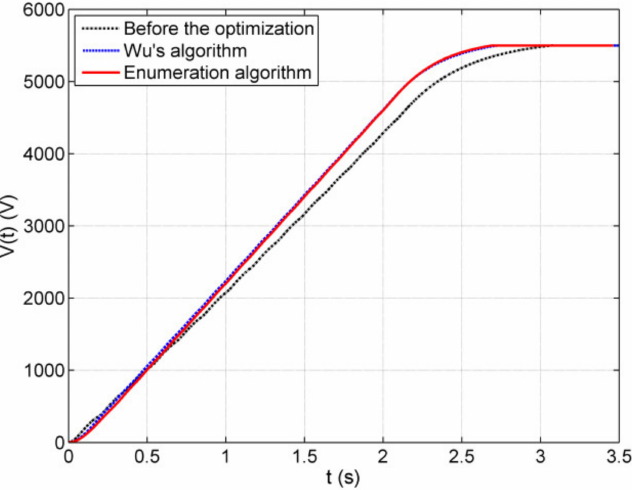
Figure 16. Charging voltage-time curves of the pulse capacitor of the two